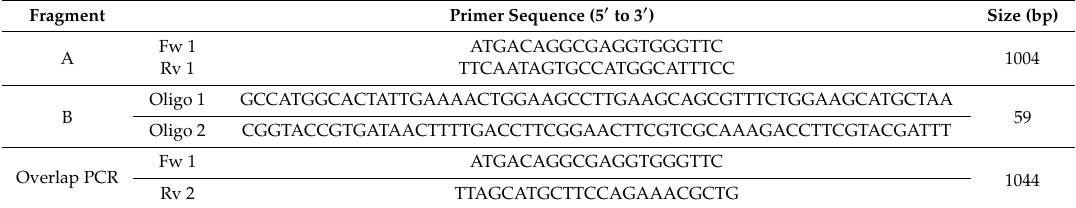
Table 8. Primers used to amplify the fragments used for overlap